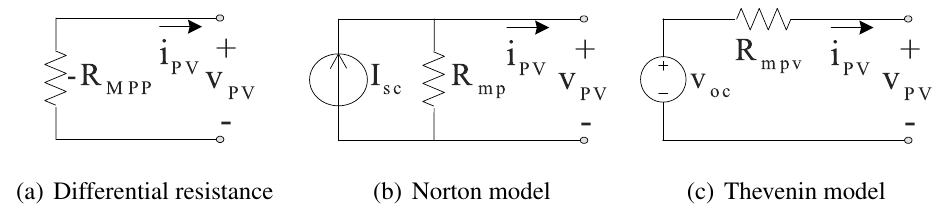
Figure 6. PVM linear models around the MPP.